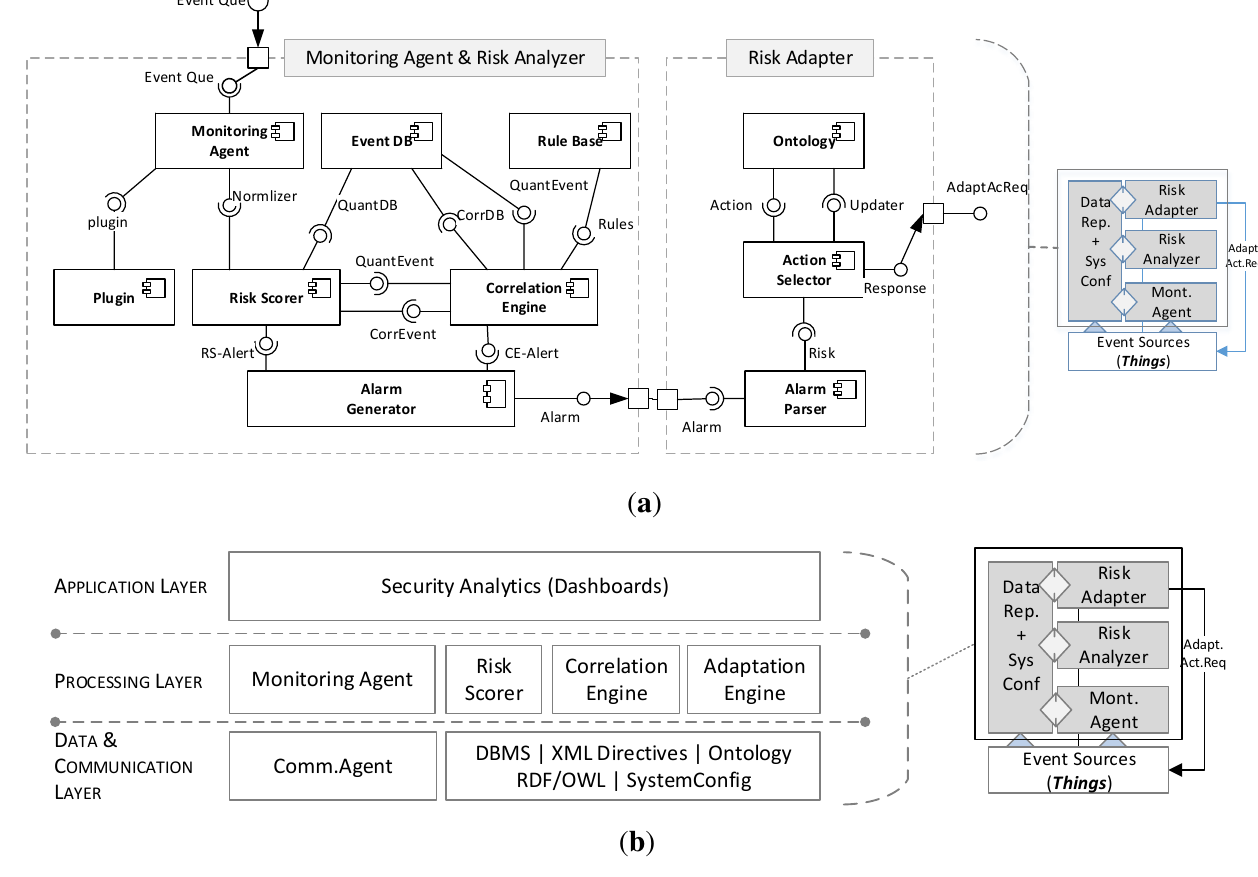
Figure 7. The EDAS platform. ( a ) EDAS platform component diagram; ( b ) The EDAS platform layered